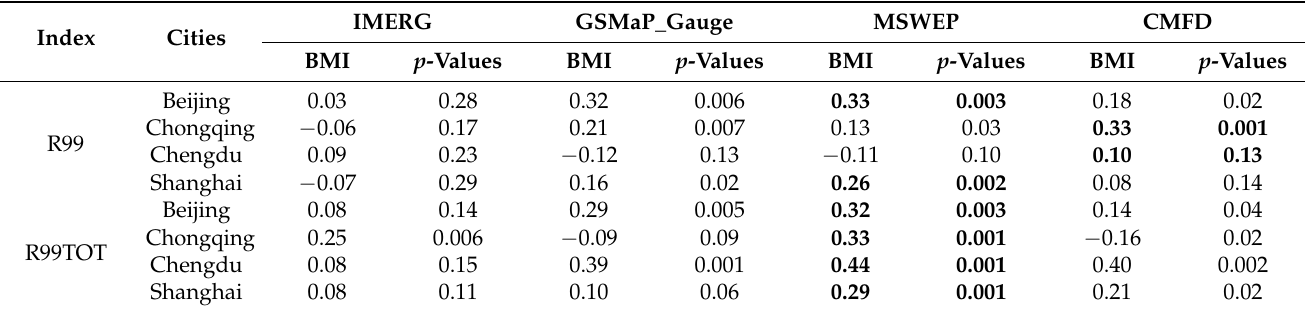
Table 6. BMI of R99 and R99TOT in four cities.